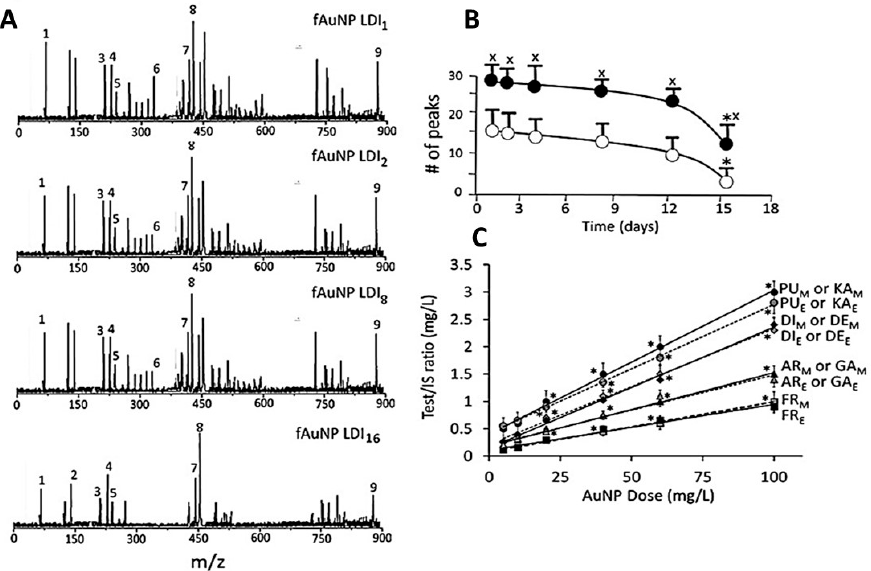
Figure 7. Identification of surface ligands on AuNPs collected from Ap/En and Ap/Ep cells. ( A ) the plant component peaks at 1 (fAuNP LDI 1 ), 2 (fAuNP LDI 2 ), 4 (fAuNP LDI 4 ), 8 (fAuNP LDI 8 ), and 16 (fAuNP LDI 16 ) days after ethanol exposure; ( B ) Time course of change in total number of peaks adsorbed onto the AuNP surface. Total number of peaks decreased significantly at day 16 (filled circle: number of peaks in matrix exposed cells, open circle: number of peaks in ethanol exposed cells). ( C ) AuNP dose versus (ligand peak/IS peak) ratio plots for surface ligands in matrix exposed (subscript M ) and ethanol exposed (subscript E ) cells. Abbreviations: PU: puerarin, KA: kakkasaponin, DI: